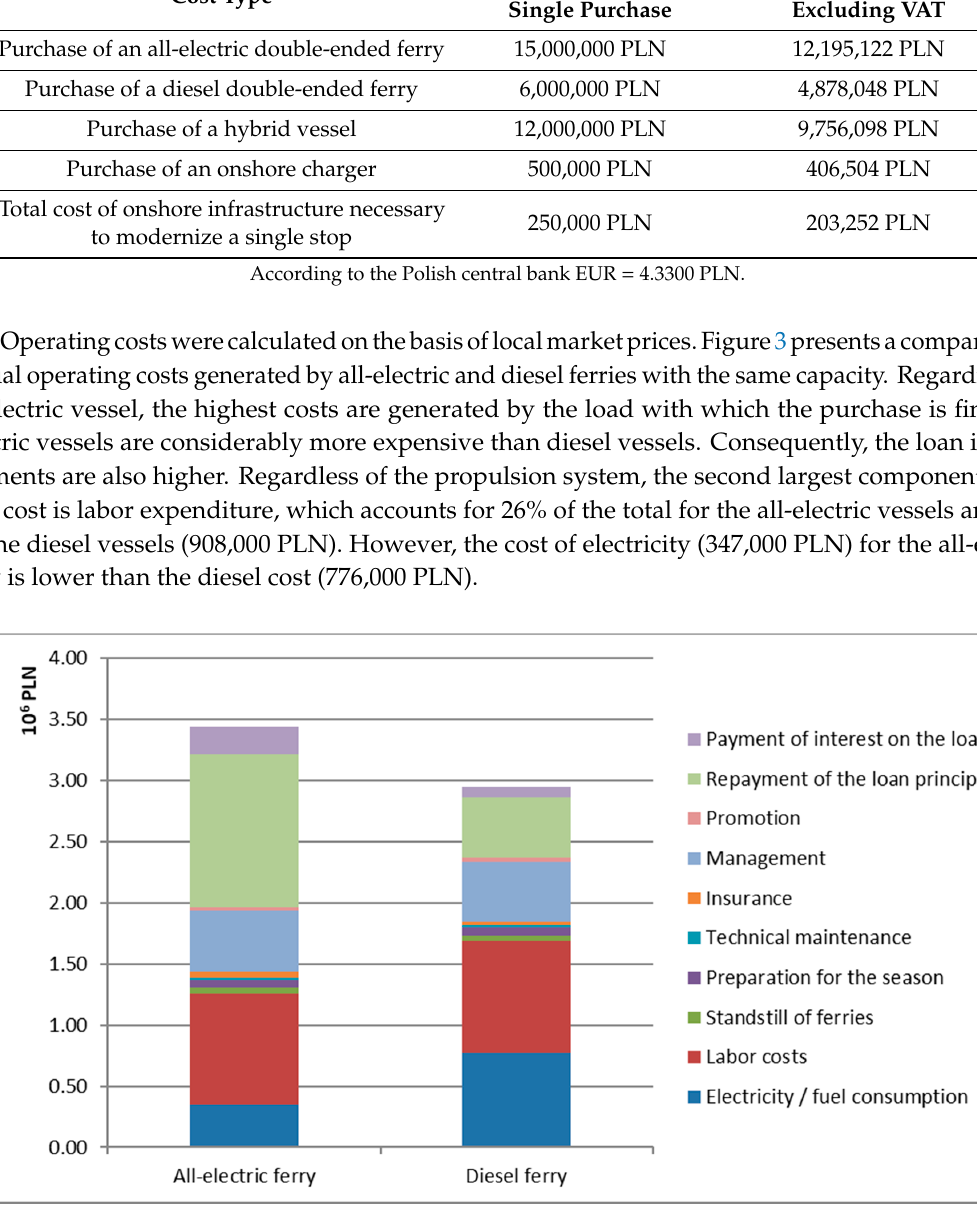
Figure 3. Annual operation costs of all-electric and diesel ferries.